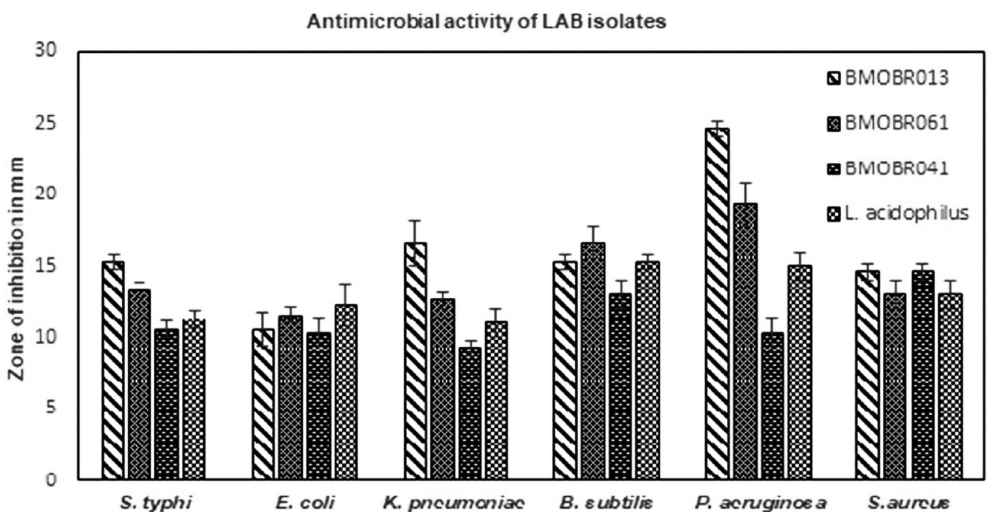
Fig 3. Antimicrobial activity of LAB isolates (A) L . pentosus BMOBR013, (B) L . pentosus BMOBR061, (C) P . acidilactici BMOBR041, (D) L . acidophilus NCIM 2285 against standard bacterial pathogens. Experiment was carried out in triplicate, and data expressed as the mean ± S.D. of three independent experiments.